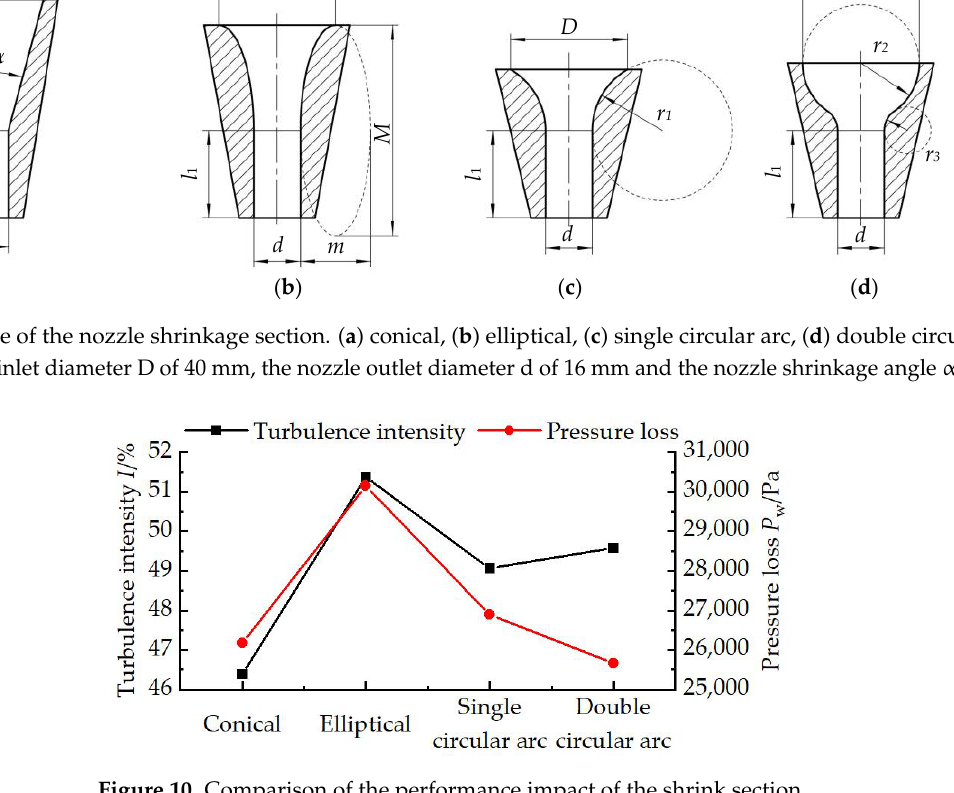
Figure 10. Comparison of the performance impact of the shrink section. Table 4. Factors and levels of influence of the orthogonal